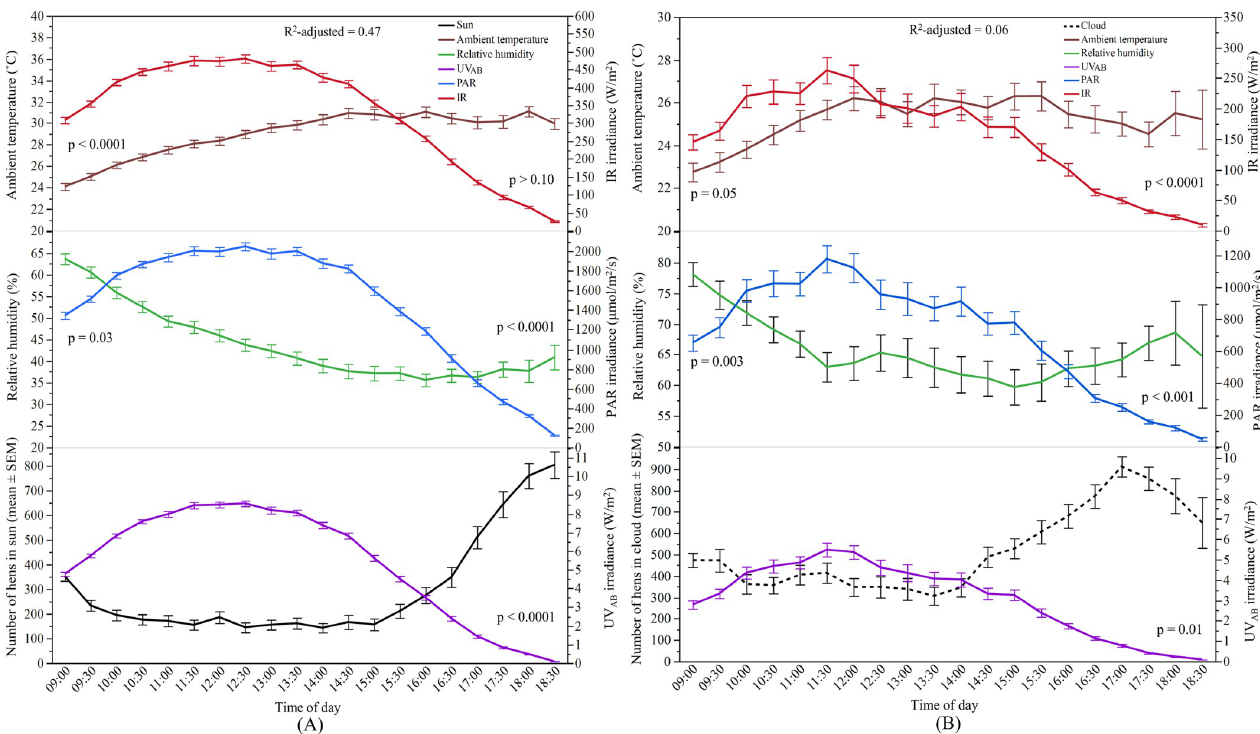
Fig 7. Relationship between sunlight spectrums and weather variables with the number of hens in the ‘sun’ and ‘cloud’ in QLD: (A) Y-axis (left): The mean ( ± SEM) number of hens in the ‘sun’, and the mean ( ± SEM) relative humidity and ambient temperature; Y-axis (right): the mean ( ± SEM) irradiance of UV AB (ultraviolet radiation A and B wavelengths), PAR (photosynthetically active radiation), and IR (infrared radiation); (B) Y-axis (left): The mean ( ± SEM) number of hens in the ‘cloud’, and the mean ( ± SEM) relative humidity and ambient temperature; Y-axis (right): the mean ( ± SEM) irradiance of UV AB (ultraviolet radiation A and B wavelengths), PAR (photosynthetically active radiation), and IR (infrared radiation). p > 0.10 indicates the variable had no significant effect and was removed from the final